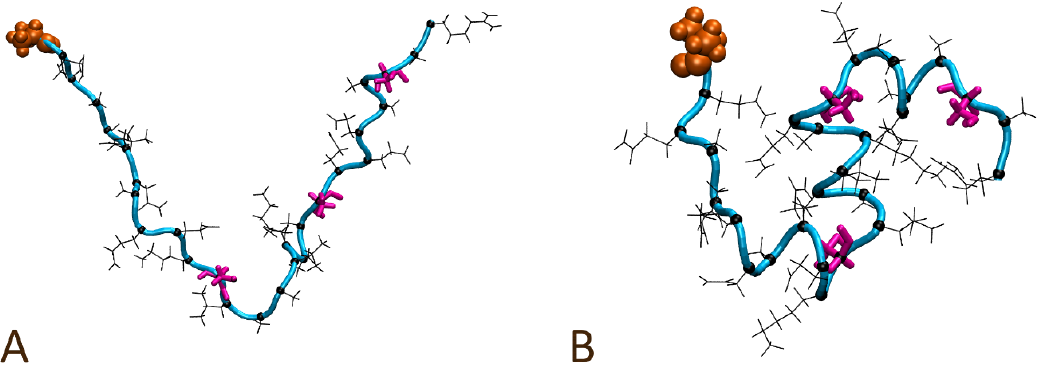
Figure 4. A solution bound single AR28 peptide modeled in an initially extended conformation ( A ) and the final observed conformation ( B ) after 100 ns. The N-terminal alanine is shown in orange; the peptide backbone atoms are depicted as the cyan tube; Ser12, Ser20, and Ser26 sidechains are colored magenta; and all other sidechains and their respective α-carbons are shown in black. Table 2. Descriptions detailing the three α-helix supporting regions observed for the solution bound single AR28 peptide modeled from an initially extended conformation, as shown in Figure 4.